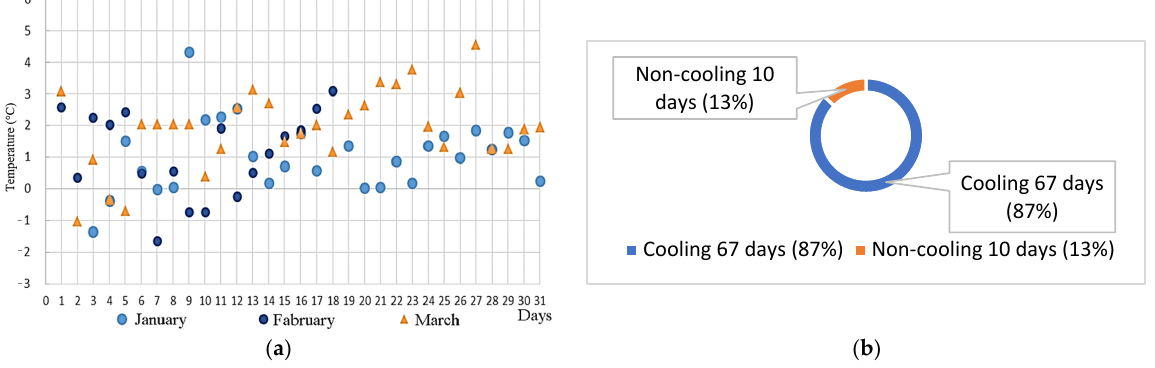
Figure 10. ( a ) Temperature distribution and ( b ) ratio of cooling days on the pervious road during